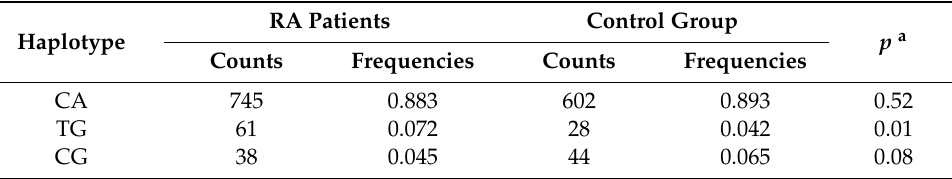
Table 2. VAV1 rs2546133 and rs2617822 haplotype